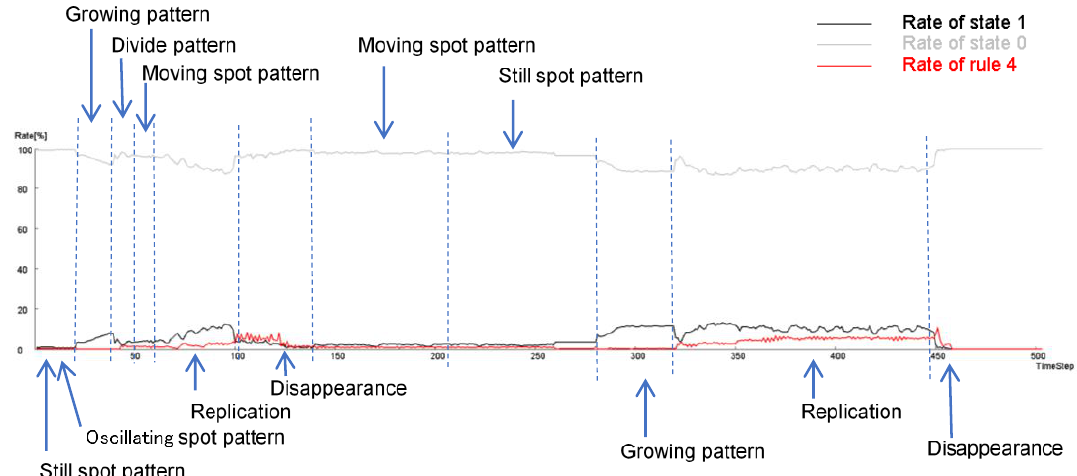
Figure 21. Transition of the ratio of states 1 and 2, and the ratio of the applied cells of Rule 4 in each time step during the calculation of Figure 20. Rule 4 was applied more frequently when spot patterns replicated than when the spot moved or vibrated. Furthermore, when the pattern disappeared, the application frequency of Rule 4 increased. Thus, it is suggested that pattern stability can be controlled by changing the application ratio of Rule 4.